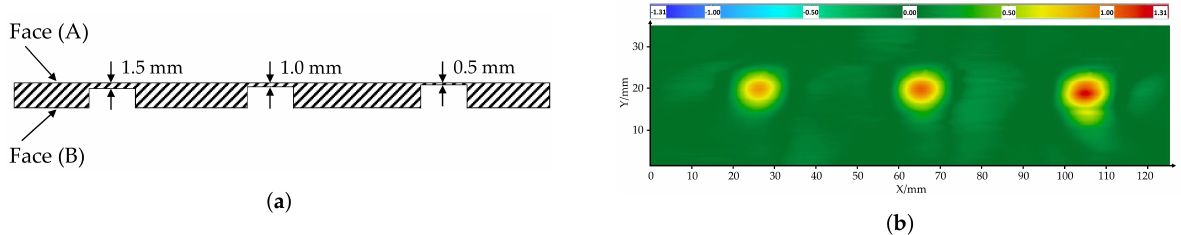
Figure 9. ( a ) Diagram of the Plexiglas specimen with three holes of different depths and ( b ) the capacitive image based on voltage values. In this image obtained from the scanning of the probe on the specimen, the striking feature is the red and yellow area, which suggests the successful detection of the defects. It can be seen that the colour of the defect-free area is green. (The reflection on the third rightmost defect is because of the mechanical